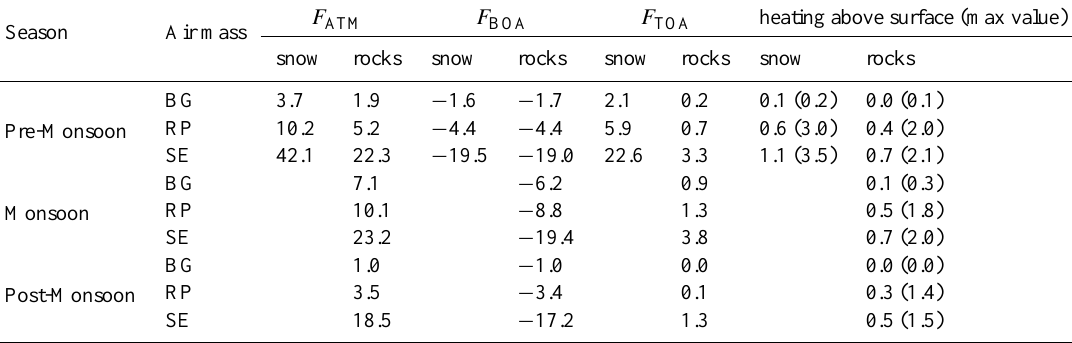
Table 2. Daily aerosol direct radiative forcing (Wm 2 /day) for the different seasons and different air masses (BG for Background; RP for regional pollution; SE for special event) at , within all the Atmosphere ( F ATM ) , at the surface ( F BOA ) and at top of atmosphere ( F TOA ) . We also report the daily heating (in K) just above the surface; the mean value of the 3 h afternoon period around the maximum is reported in parenthesis. F ATM F BOA F TOA heating above surface (max value) Season Air mass snow rocks snow rocks snow rocks snow rocks